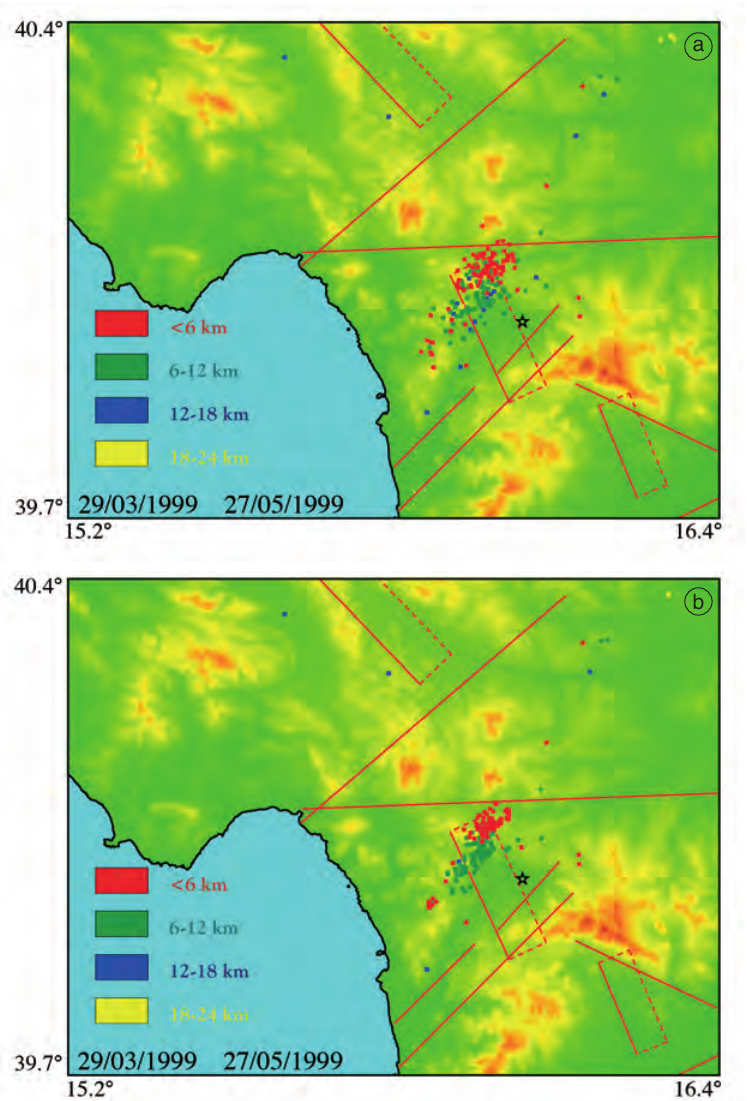
Fig. 6a,b. Comparison of the surface distribution of the epicentres a) before and b) after the application of the Bossu (2001) method. Here and in the following figures, colours correspond to different depth